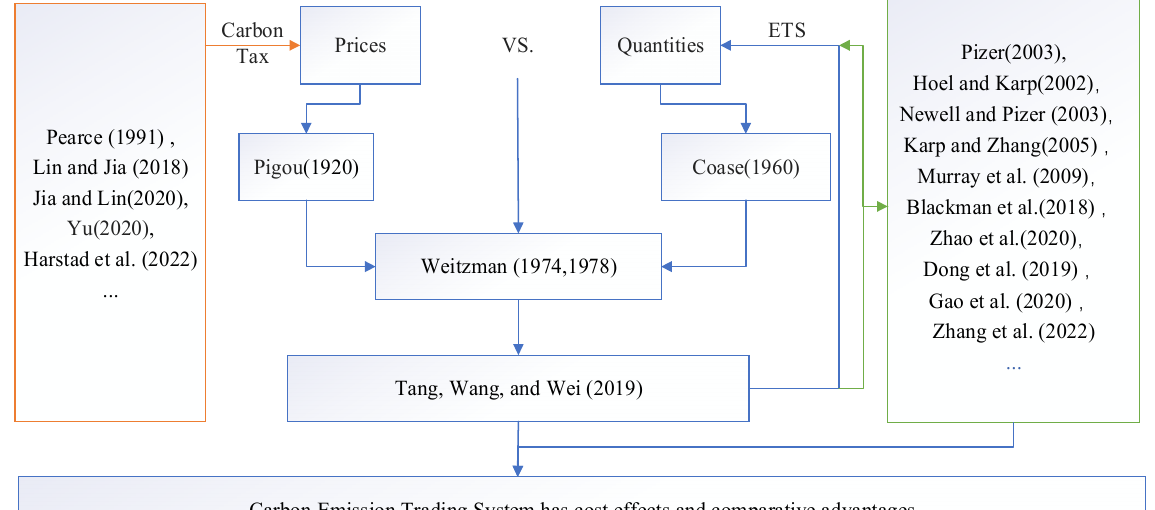
Figure 8. Prices vs. quantities; ETS has cost effects and comparative advantages [13–33]